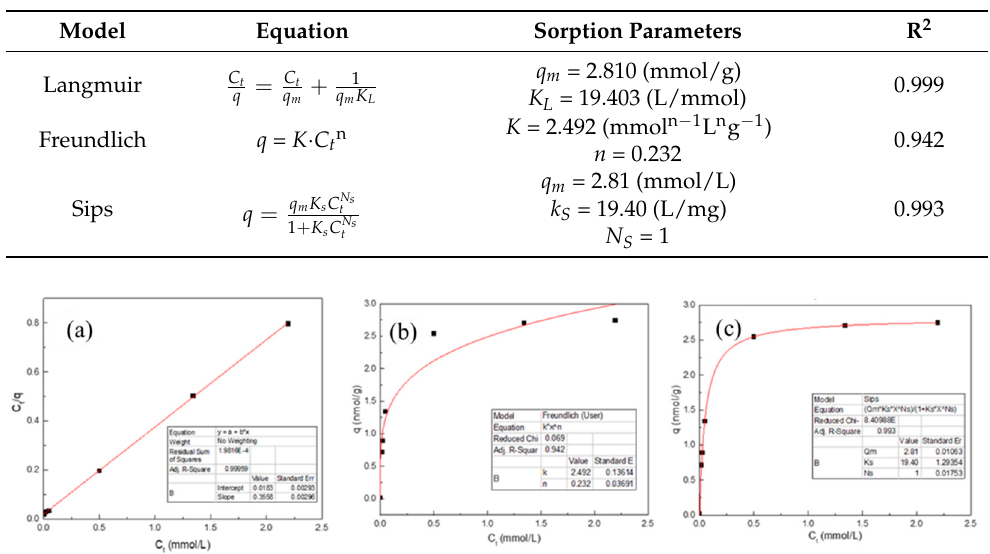
Figure 7 . Effect of temperature on the transformation efficiency of Fe( Ⅲ ) . Table 2. Correlations coefficients and sorption parameters obtained using Langmuir, Sips and Freundlich models.